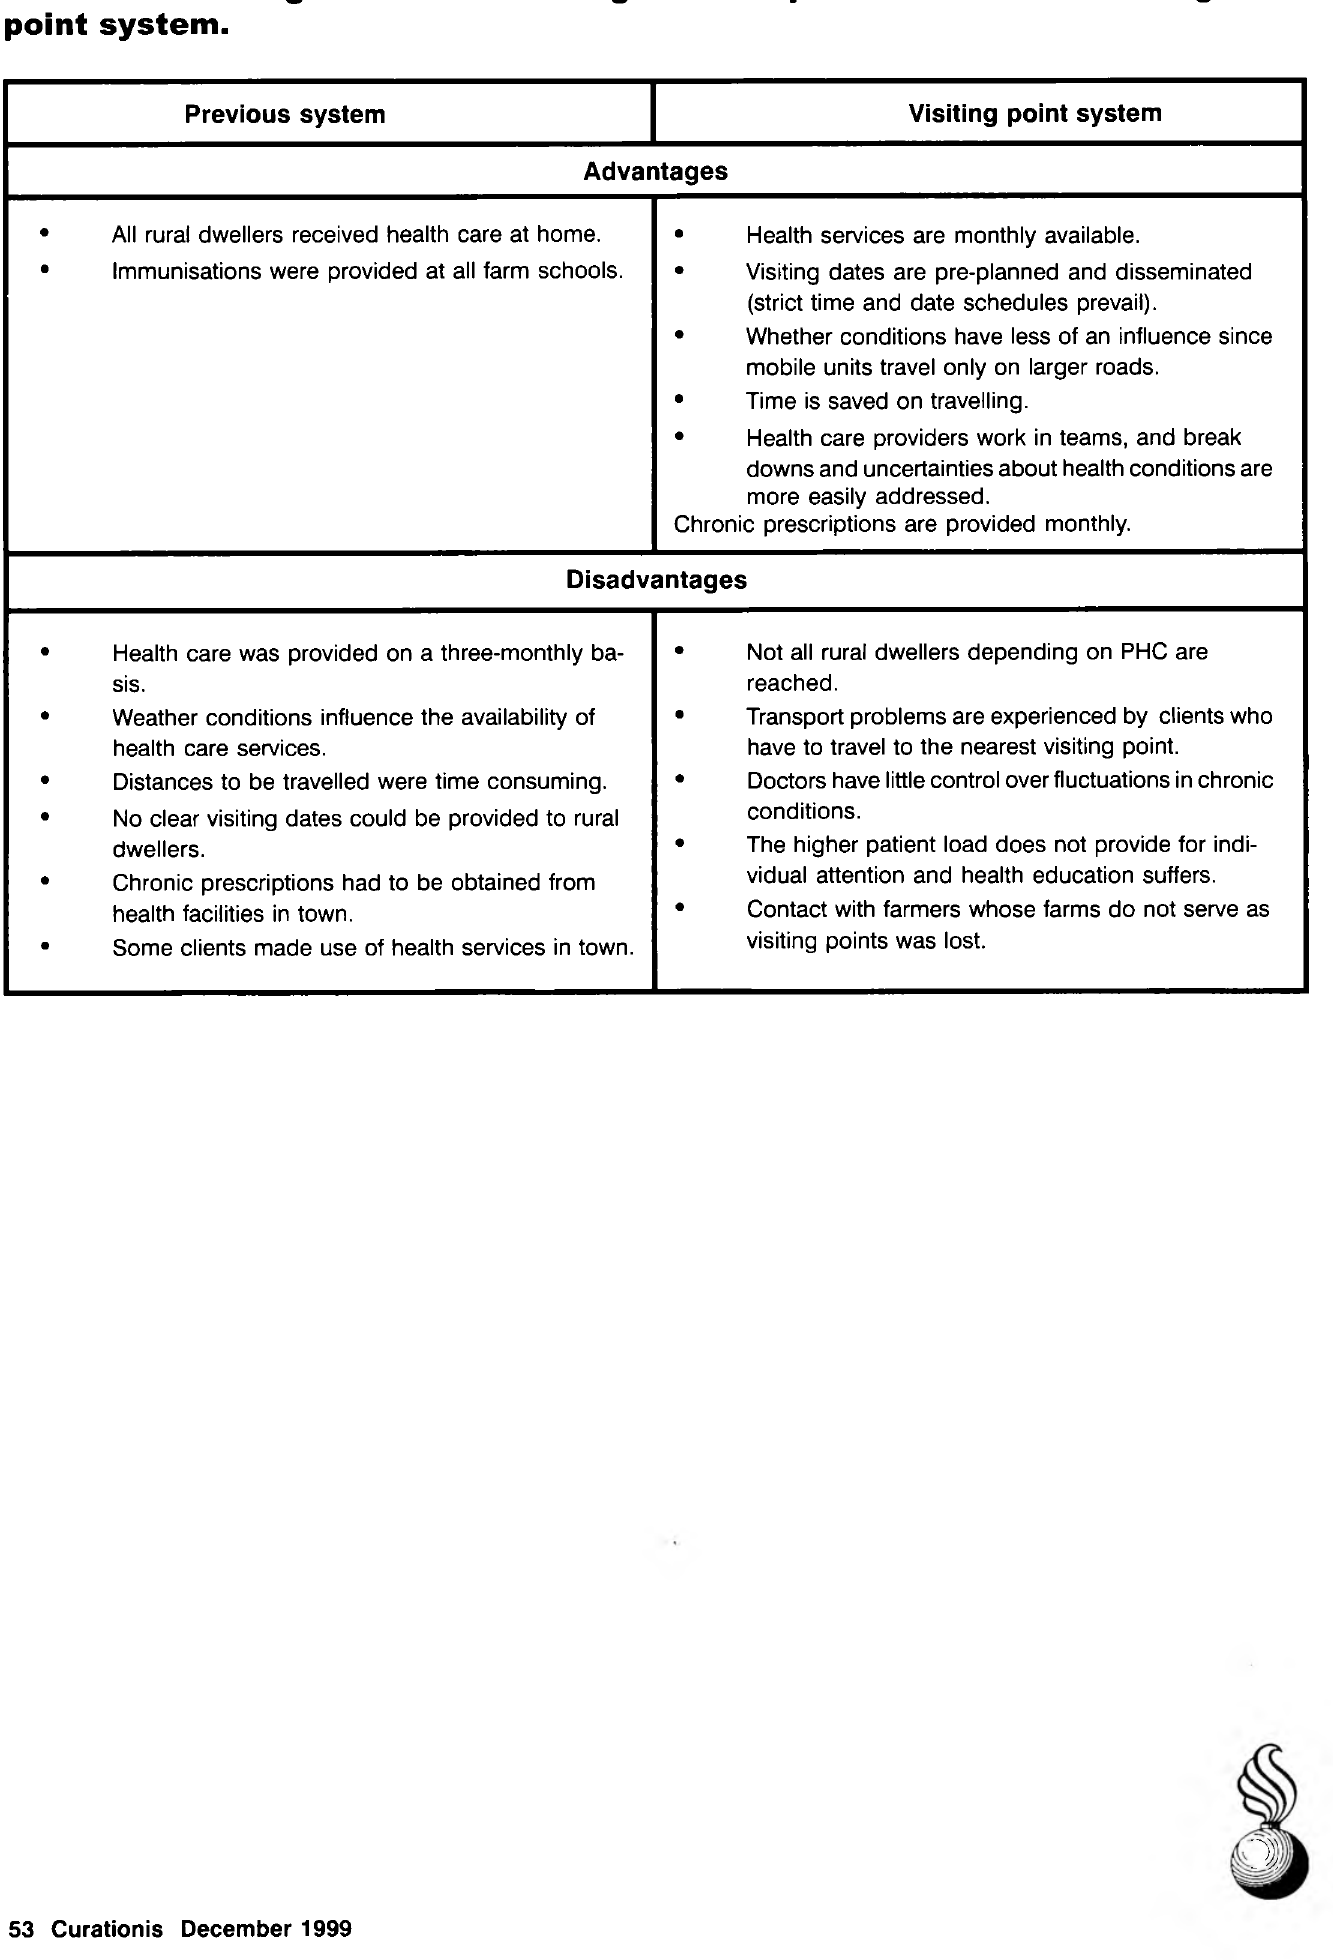
Table 1: Advantages and disadvantages of the previous and new visiting point system